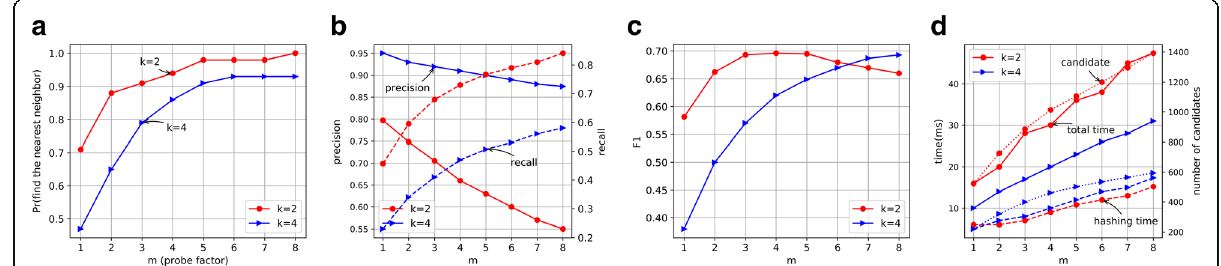
Fig. 6 The effect of the bin number k on the algorithm. a m versus the probability of find the nearest neighbor and precision/recall/F1. b m versus the number of candidates and precision/recall/F1. c m versus the probability of find the nearest neighbor and query/hashing time. d m versus the number of candidates and query/hashing time